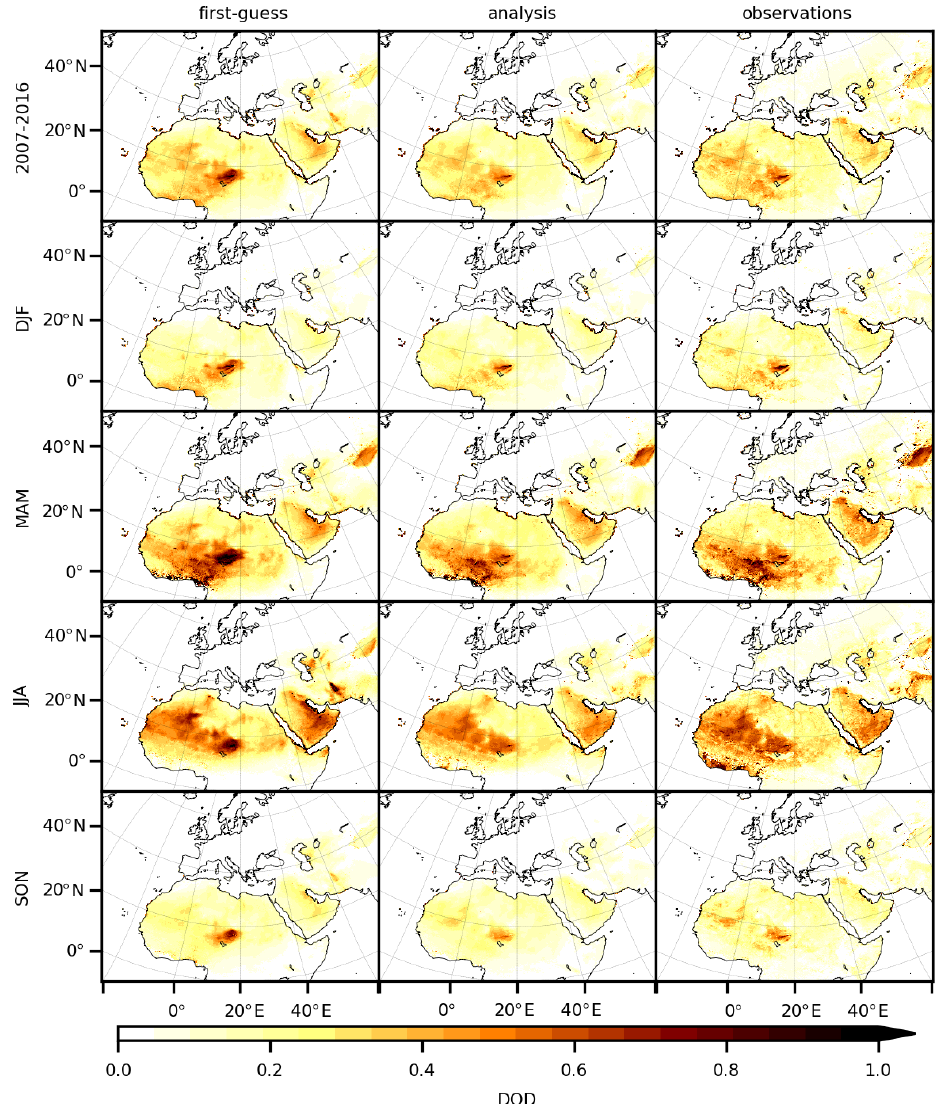
Figure 7. Maps of mean 3-hourly DOD coarse first guess (first column), analysis (second column) and MODIS DB assimilated observations (third column) calculated for the whole period (2007–2016; top row) and for different seasons (DJF, MAM, JJA, SON; rows 2 to 5). Model fields are the ensemble mean and are collocated with the